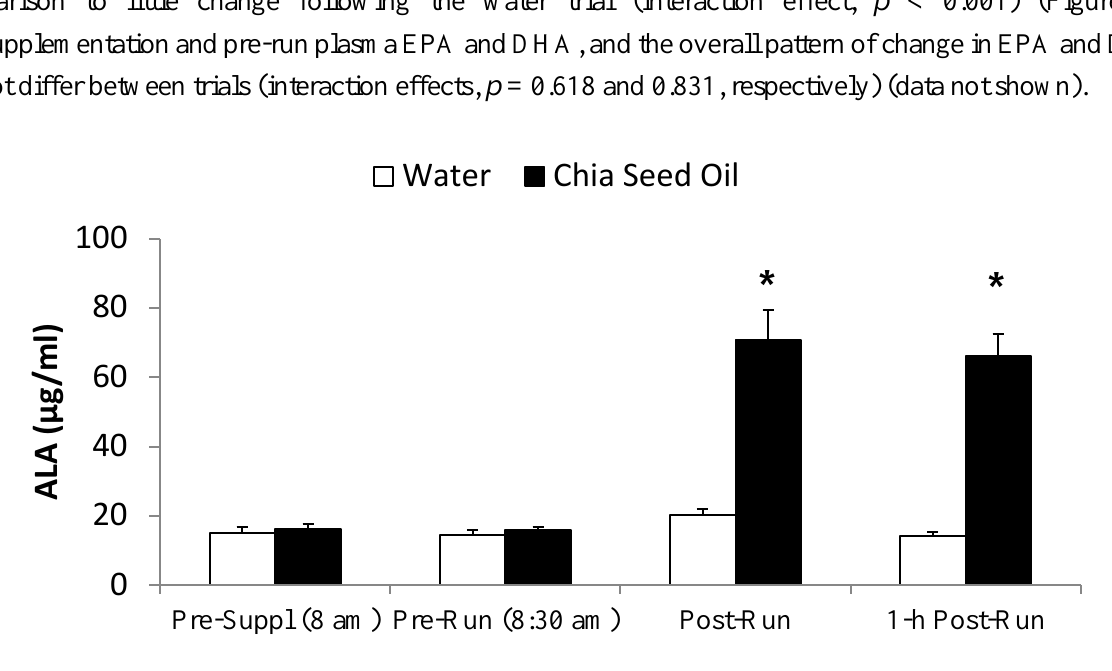
Figure 2. Comparison between water and chia seed oil trials for ALA (interaction effect, p < 0.001) in runners ( n = 24) (mean ± SE). * p < 0.025, change from pre-supplementation, relative to